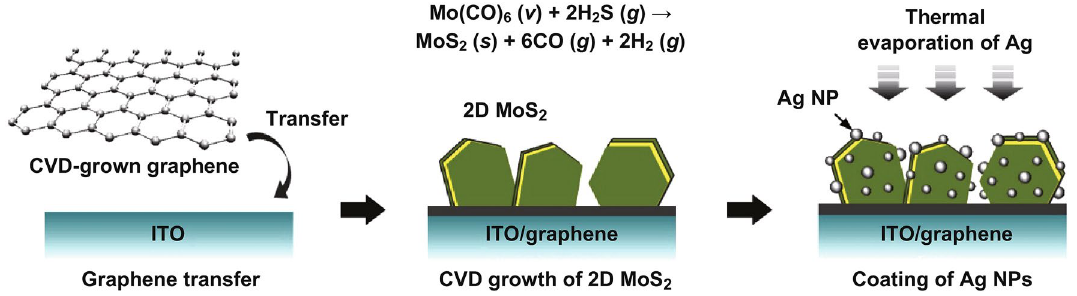
Fig. 1 Schematic of preparation of plasmonic Ag‑decorated vertically aligned few‑layer MoS 2 nanosheets on